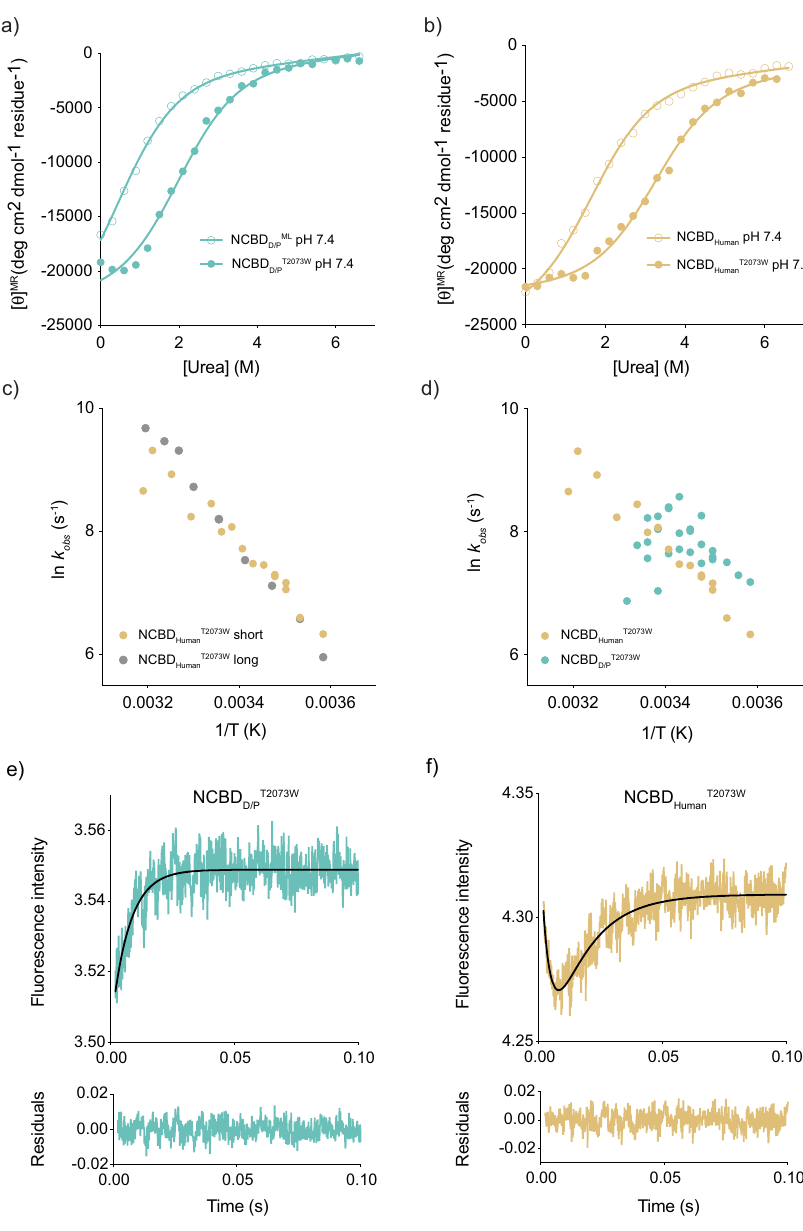
T2073W (teal) fi tted to a single D/P